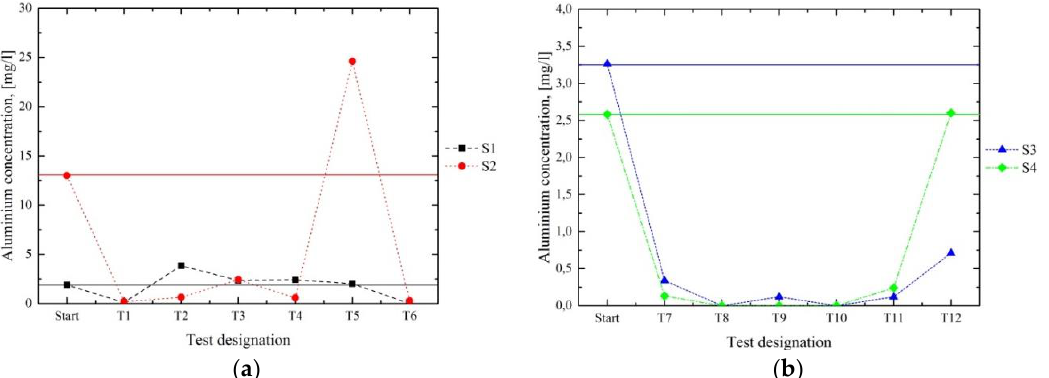
Figure 8. Concentration of aluminium in the initial solutions (start, continuous line) and in the filtrates of series 1 ( a , T1–T6) and series 2 ( b , T7–T12) [3].